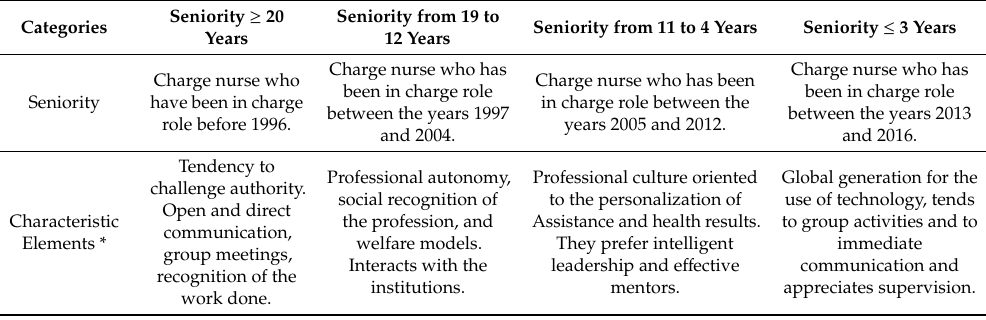
Table 2. Rationale of the seniority of the charge